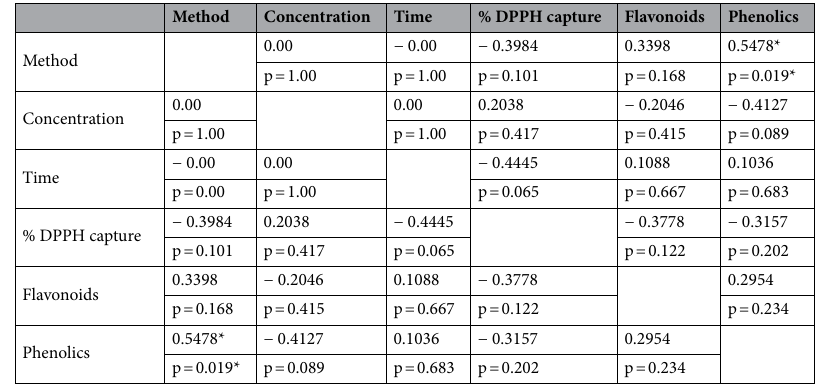
Table 7. Pearson correlation for the ethanol extract. *Results statistically significant.